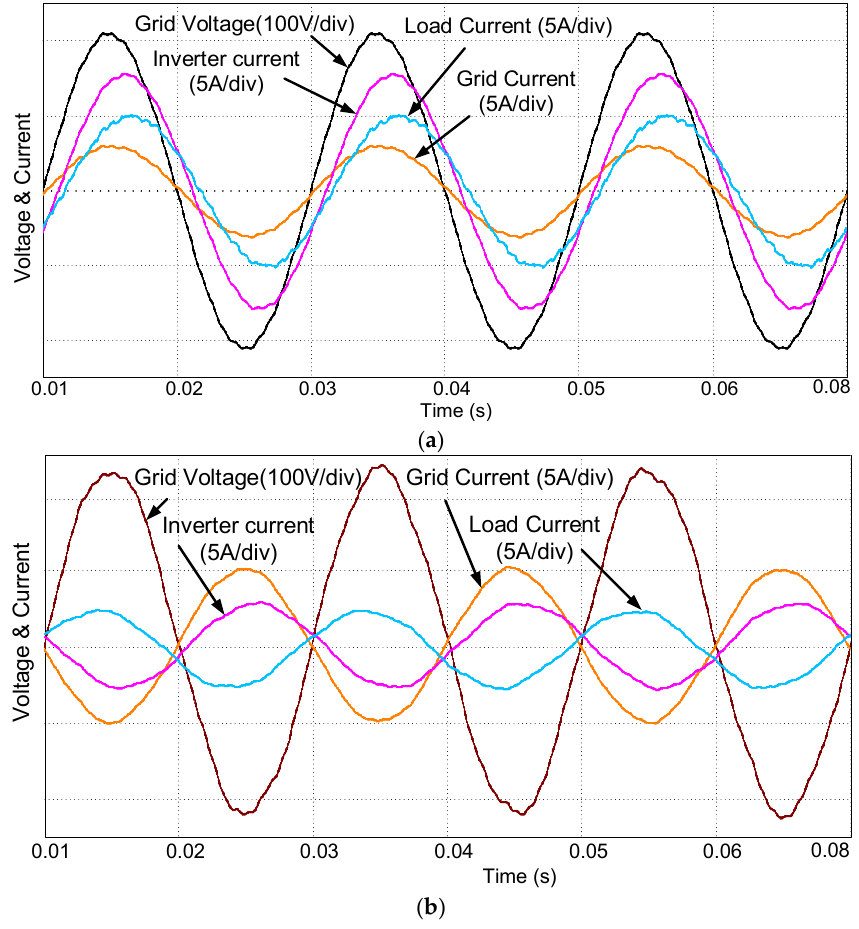
Figure 10. The inverter output, load and the grid currents ( a ) when power is transferred from the inverter to the grid and the load, and ( b ) when inverter is operating as rectifier and power is transferred in the opposite direction, from grid to the load and battery, reduced back to the previous value.